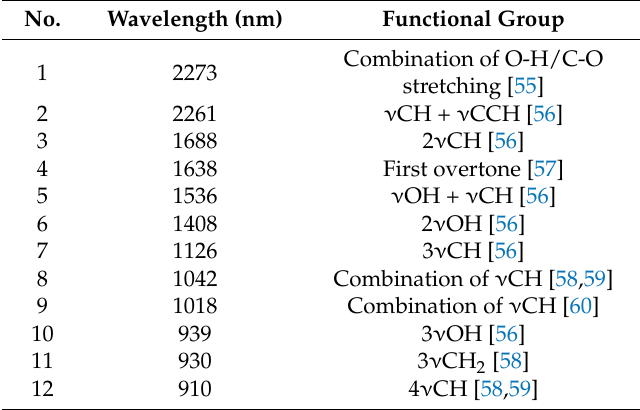
Table 1. Absorption peaks of glucose in the NIR region and the corresponding functional groups. No. Wavelength (nm) Functional Group Combination of O-H/C-O 1 2273 stretching [55] 2 2261 ν CH + ν CCH [56] 3 1688 2 ν CH [56] 1638 First overtone [57] 1536 ν OH + ν CH